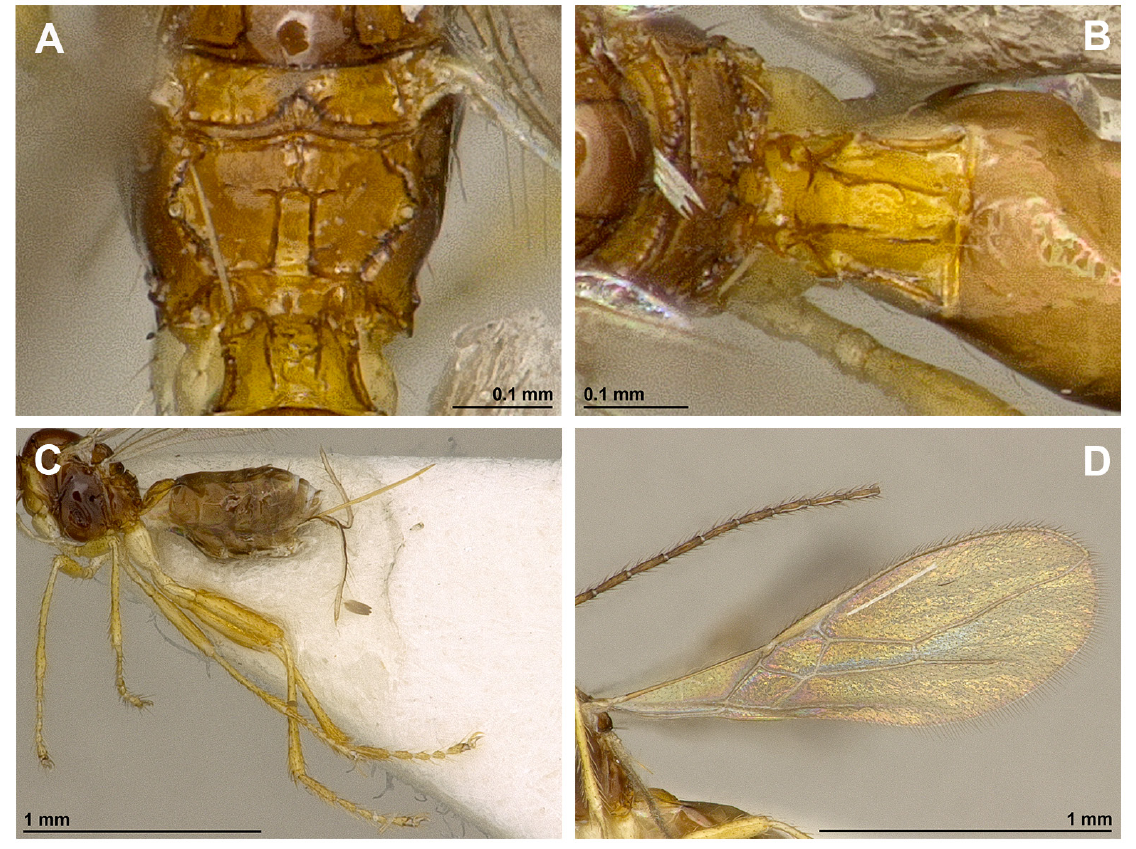
Fig. 73. Asobara vanharteni van Achterberg, sp. nov., ♀, holotype (RMNH). A . Propodeum. B . First metasomal tergite, dorsal view. C . Hind leg, metasoma and ovipositor, lateral view. D . Fore